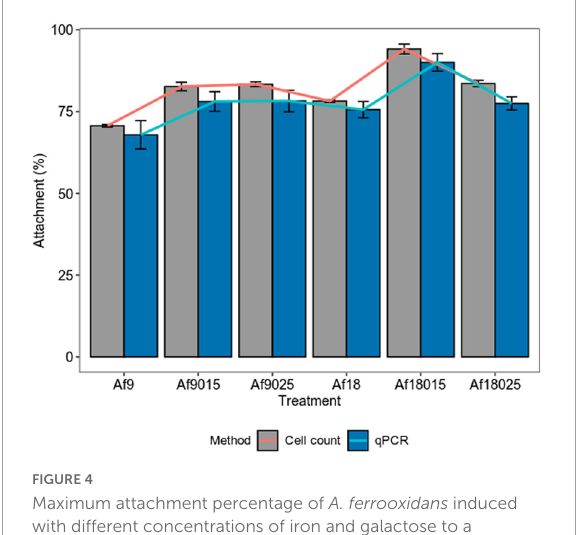
FIGURE4 Maximum attachment percentage of A. ferrooxidans induced with different concentrations of iron and galactose to a polymetallic sulfide ore. Bars represent the maximum attachment percentage and lines represent the increase in attachment compared to the control assay (Af9). The data correspond to the mean values of triplicates ± SD ( n =